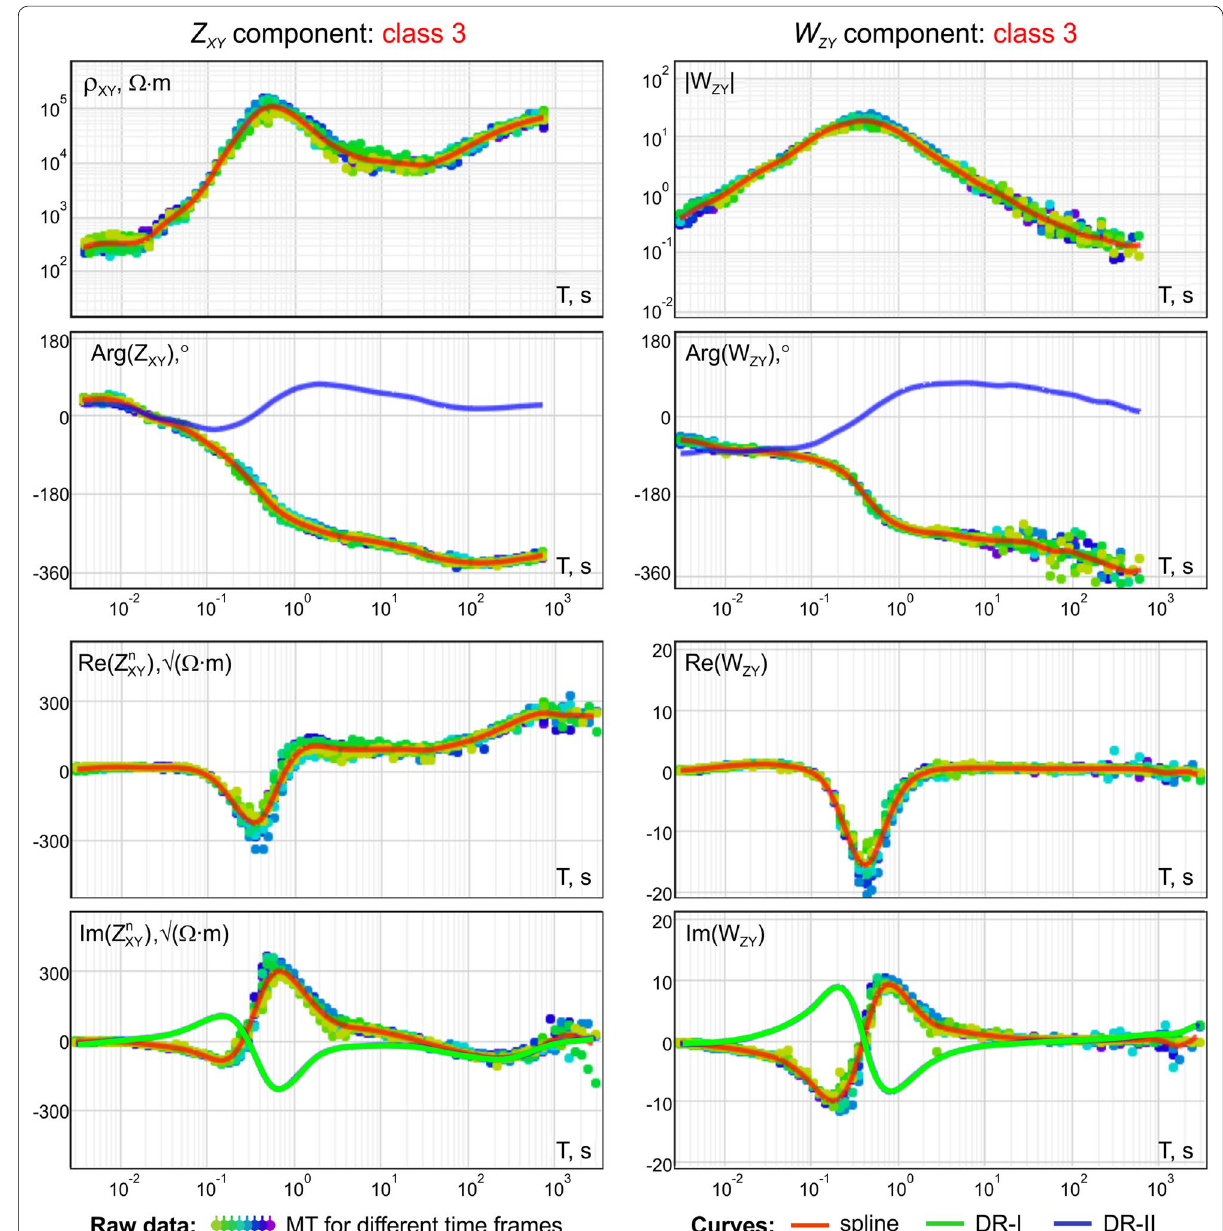
Fig. 17 Non-causal MT response functions acquired near an out-of-service railroad (site 932G, Eastern